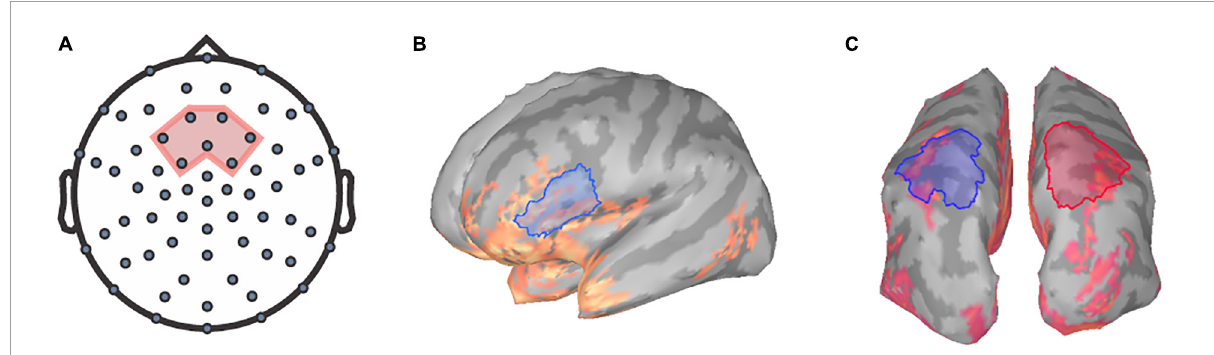
FIGURE1 Regions of interest for TRF and frequency analysis. The seven frontocentral channels, EEG channels (A) chosen for TRF analysis are within the region shaded in red. Relative alpha power was extracted at the (B) left inferior-frontal gyrus and the (C) superior-parietal regions for both hemispheres (left in blue, right in